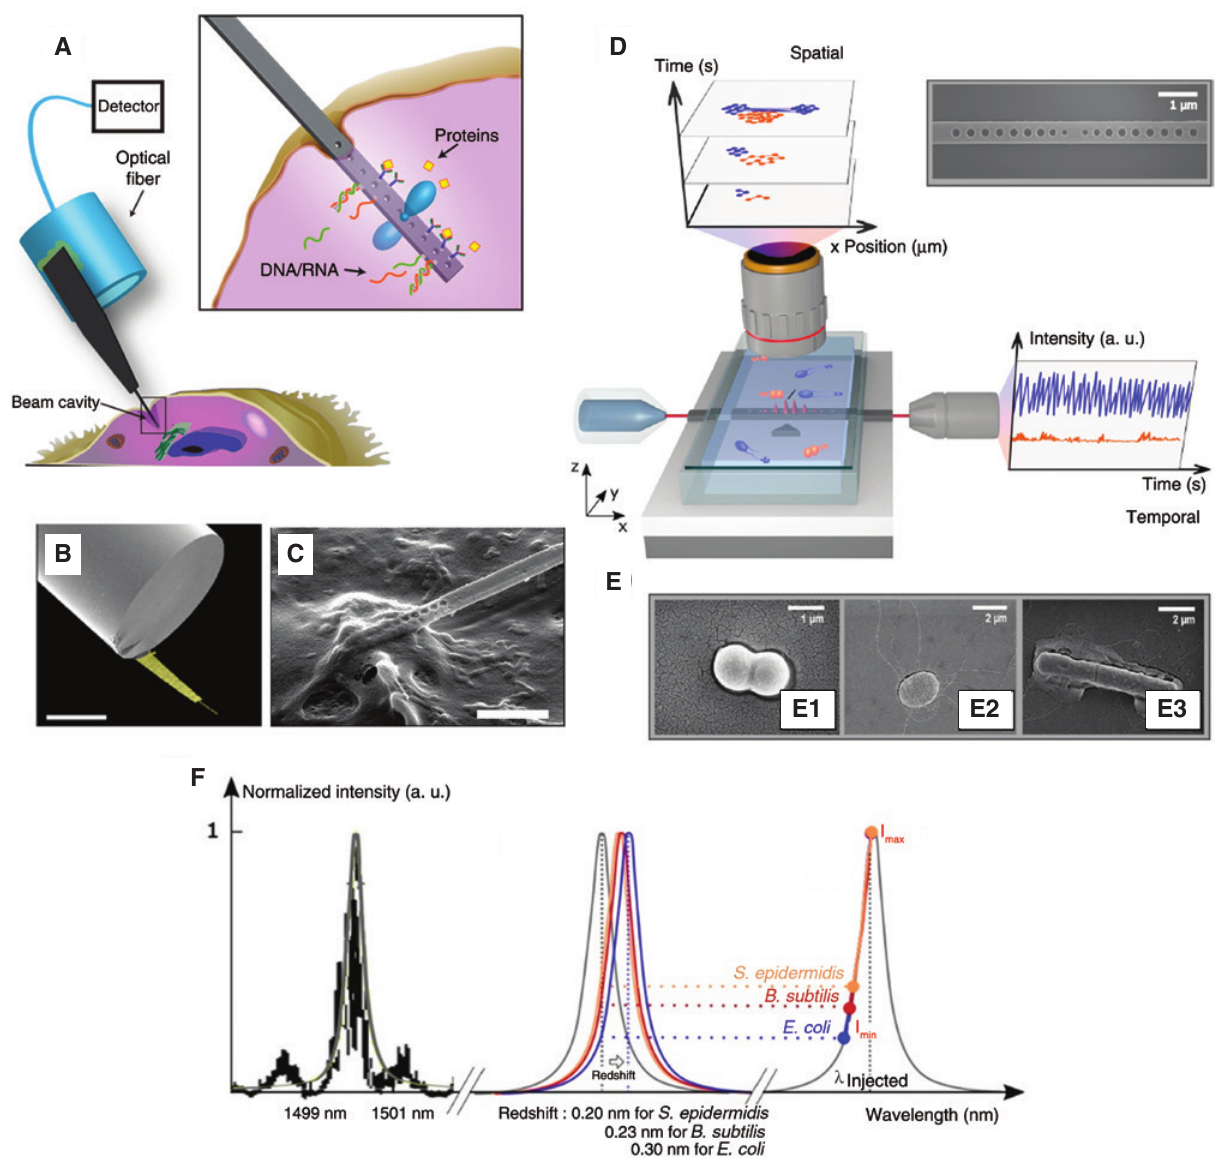
Figure 28: In vivo operation of photonic crystal nanobeam sensors. (A) Diagram of the PhC nanobeam inserted into a cell, probing for DNA/RNA and proteins. (B) Pseudocoloured SEM image of a typical fabricated nanoprobe device (scale bar = 50 μ m) and (C) an SEM image of a cell punctured by the nanobeam (scale bar = 2 μ m).